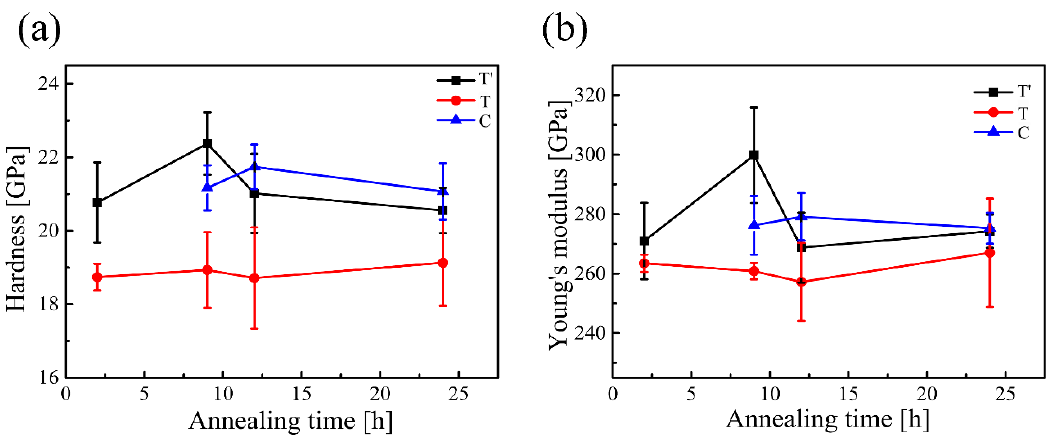
Figure 8. ( a )Nano-indentation hardness ( b )Young’s modulus as a function of annealing